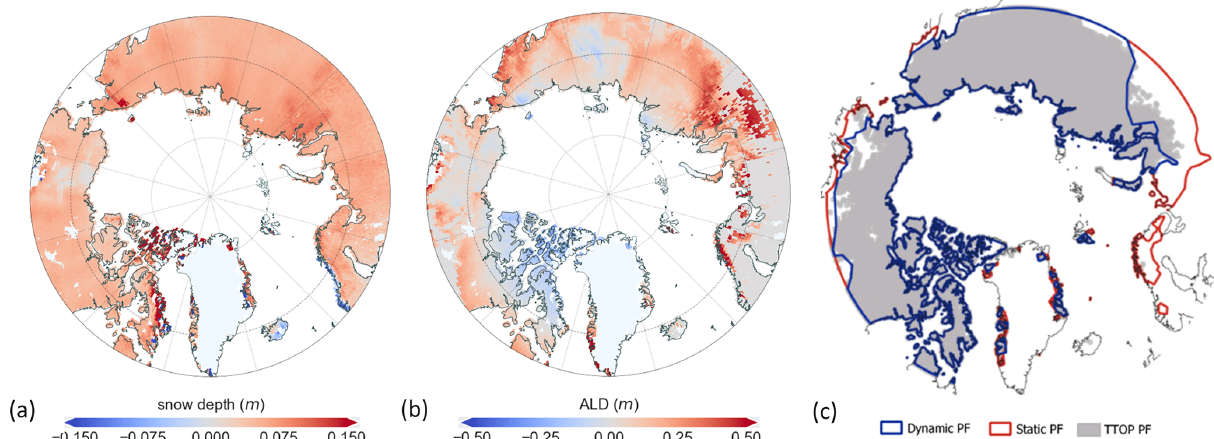
Figure 6. (a) Snow depth difference in winter months and (b) maximum ALD difference, calculated by subtracting the Static from Dynamic simulation outputs. Modelled permafrost extent is based on mean annual ground temperature (MAGT) and plotted against the permafrost cover estimate by Obu et al. (2019a) (TTOP model). Simulated absolute snow depth is shown in Fig. S2 in the Supplement and ALD in Fig. S3 in the Supplement.